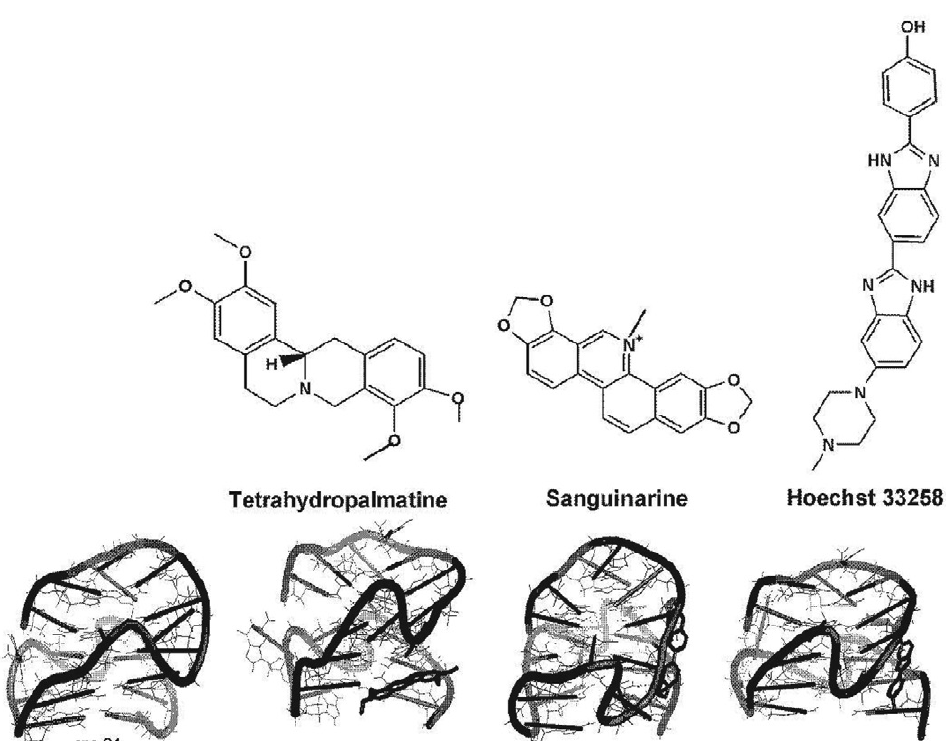
Figure 6. Groove binding of Tetrahydropalmatine, Sanguinarine and Hoechst 33258 to apo (ligand-free) G4 from the c-Myc promoter in the stable regime of molecular dynamics (MD) simulation. In a representative set of structurally diversified ligands, these three molecules were established to have the highest affinity for G4. Only Tetrahydropalmatine was shown to be a thermodynamically favorable binder by increasing the conformation- al flexibility of G4 in the asymptotic ( t →∞) regime of MD simulation.